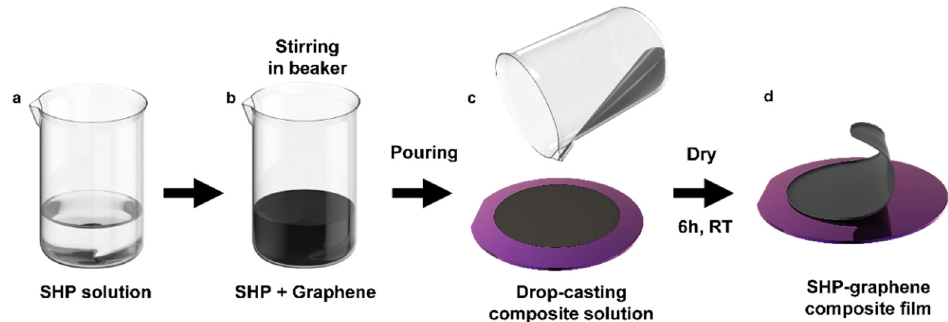
Figure 1. Schematics for the fabrication processes. ( a ) Stirring SHP solution dissolved in chloroform. ( b ) Introduction of graphene powders in the beaker. ( c ) Drop-casting on OTS-treated wafer. ( d ) Peeling off the SHP–graphene composite on the wafer after 6 h.